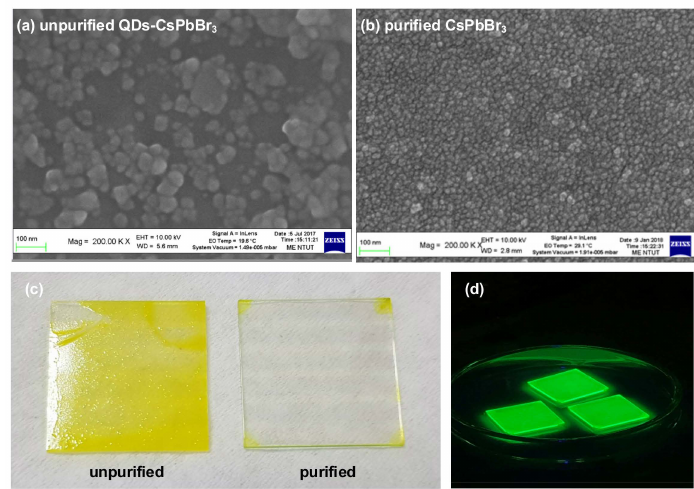
Figure 7. Top-view SEM images of ( a ) unpurified QDs-CsPbBr 3 ; ( b ) purified QDs-CsPbBr 3 covered onto glass substrates; ( c ) unpurified and purified QDs-CsPbBr 3 -coated glass films; and ( d ) highly luminescent purified QDs-CsPbBr 3 films ( λ = 365